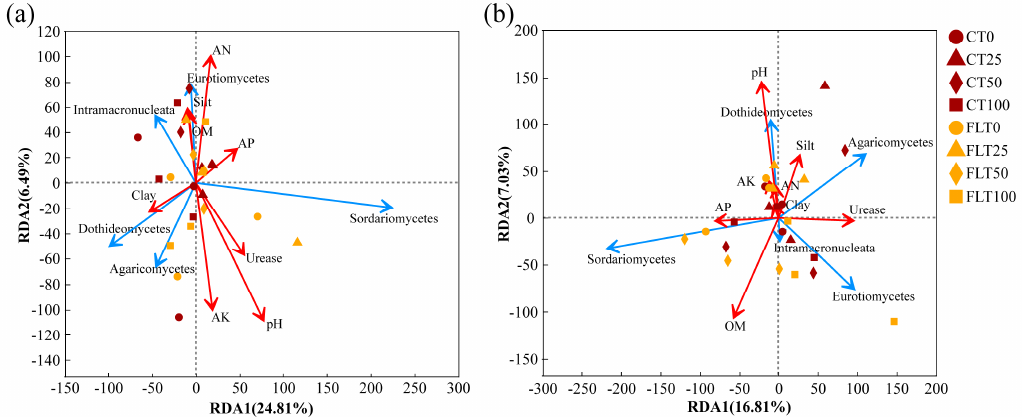
Figure 6. Redundancy analysis (RDA) of the fungal community structure at the class level associated with the physicochemical properties of cassava rhizosphere soil collected in 2019 ( a ) and 2020 ( b ), respectively. The direction of the red arrow indicated the soil factors associated with changes in the community structure, and the length of the arrow indicates the magnitude of the association. The blue arrows were the top five fungi at the class level. OM, organic matter; AN, available nitrogen; AP, available phosphorus; AK, available potassium.